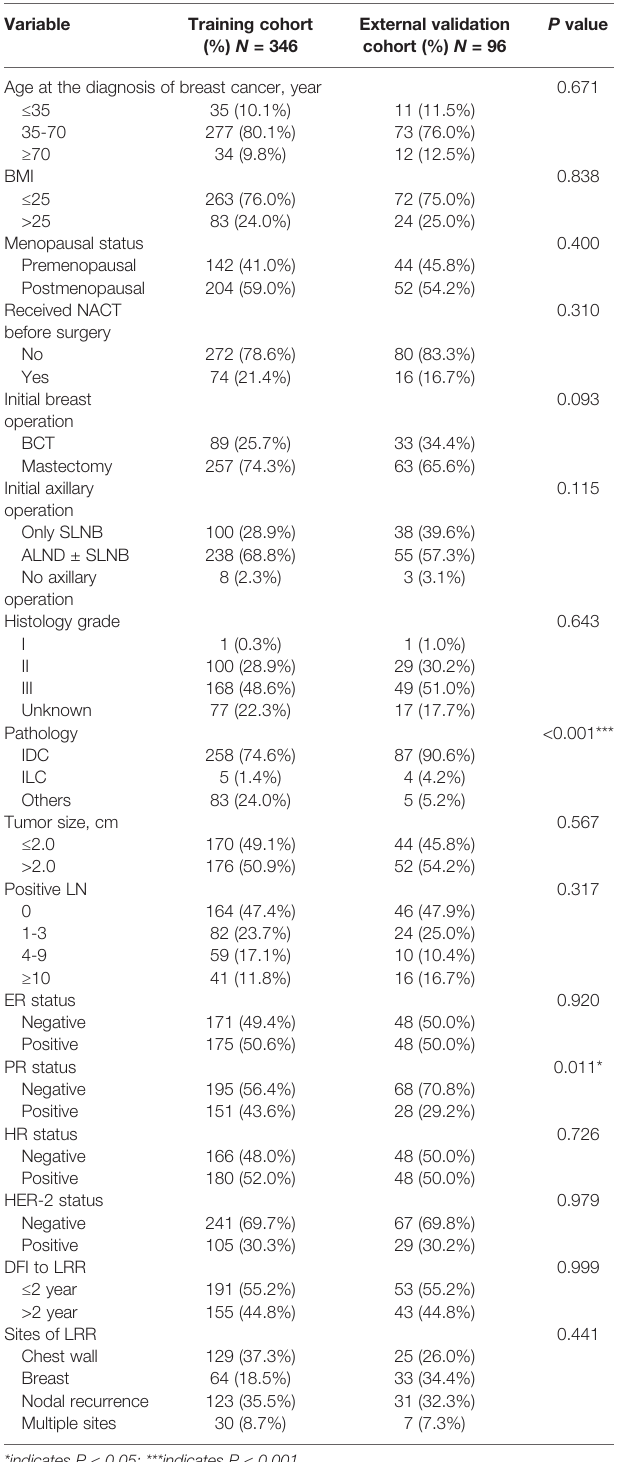
TABLE 1 | Baseline characteristics of breast cancer patients with